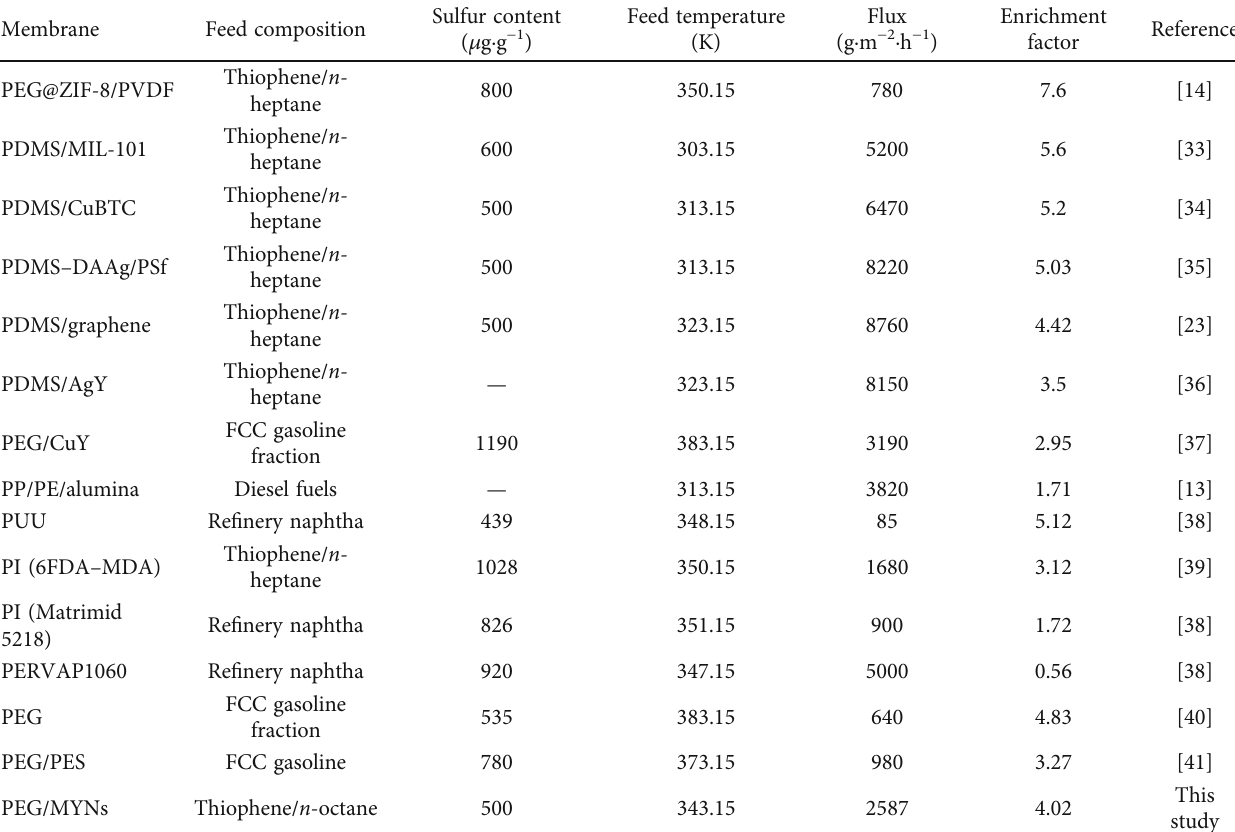
Table 1: PV desulfurization performance of the PEG/MYNS MMMs and other membranes reported in the literature.